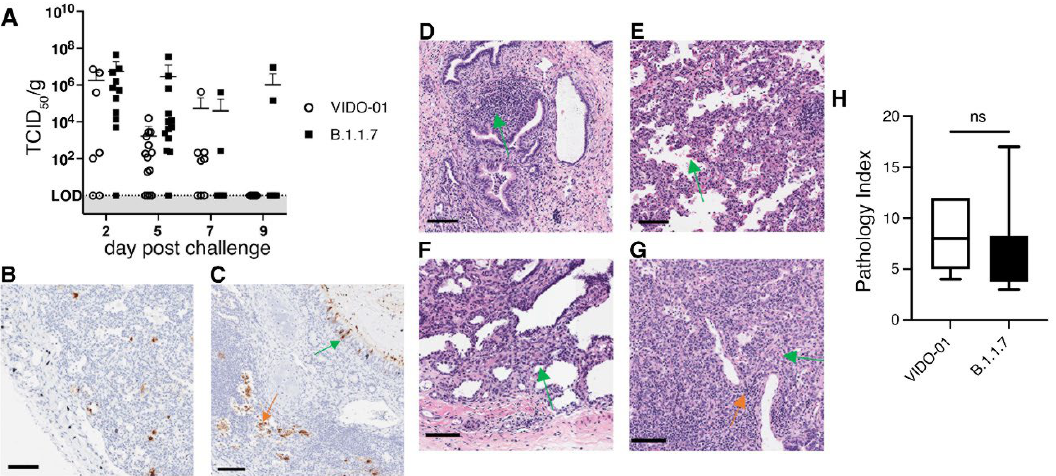
Figure 4. Differences in infectivity and viral persistence between SARS-CoV-2 variants was detectable in TKO-BLT-L mice. TKO-BLT-L mice were challenged via intra-organoid injection of 1 × 10 5 TCID 50 of either VIDO-01, an early B lineage (D614) virus, or the B.1.1.7 Alpha variant of concern and ( A ) organoids harvested at days 2, 5, 7 and 9 post-challenge to evaluate the live viral titer per gram of tissue. Each symbol represents an individual lung organoid harvested from TKO-BLT-L mice produced from a total of eight different human donors. Horizontal lines denote mean ±SD. LOD = Limit of detection. Organoids harvested at day 5 post-challenge were either ( B , C ) stained for SARS-CoV-2 N protein (brown) or (D-G) H&E stained to assess for SARS-CoV-2-related pathology. N protein staining of ( B ) alveolar macrophages ( C ) ciliated bronchial epithelia (green arrow) and desquamated epithelial cells (orange arrow), ( D ) epithelial cell/mucosa lymphocyte infiltration, ( E ) extravasated erythrocytes, ( F ) type-2 pneumocyte hyperplasia, ( G ) perivascular lymphocyte infiltration (orange arrow) and apoptotic bodies (green arrow). ×20 magnification, scale bars, 100 µm. Representative staining is shown in organoids infected with either VIDO-01 or B.1.1.7. ( H ) Histological scoring of lesions (pathology index) of lung organoids at day 5 infected with either VIDO-01 or B.1.1.5. Unpaired t- test, ns = not s ignificant.